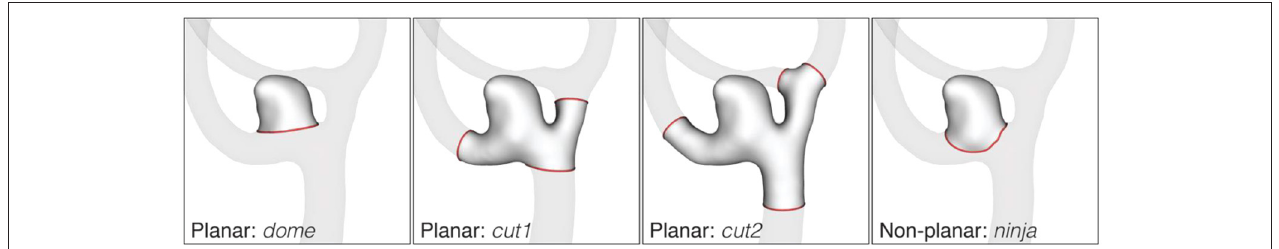
FIGURE 3 | Cut configurations of the AneuX morphology database. Cut lines are shown in red. The dome cut disjoins the aneurysm dome from the parent vasculature by one single planar cut. For cut1 and cut2 , cut planes are placed perpendicularly to the local centerline in one or two vessel diameters distance from the dome . If the rule could not be applied because of an adjacent bifurcation, the closest valid cut before or after the bifurcation was chosen. The non-planar ninja cut was placed along the boundary (the so-called neck) of the aneurysmal protrusion. Like the dome cut, a ninja cut captures the aneurysm dome, but permits a more natural isolation of the aneurysm as assessed by the